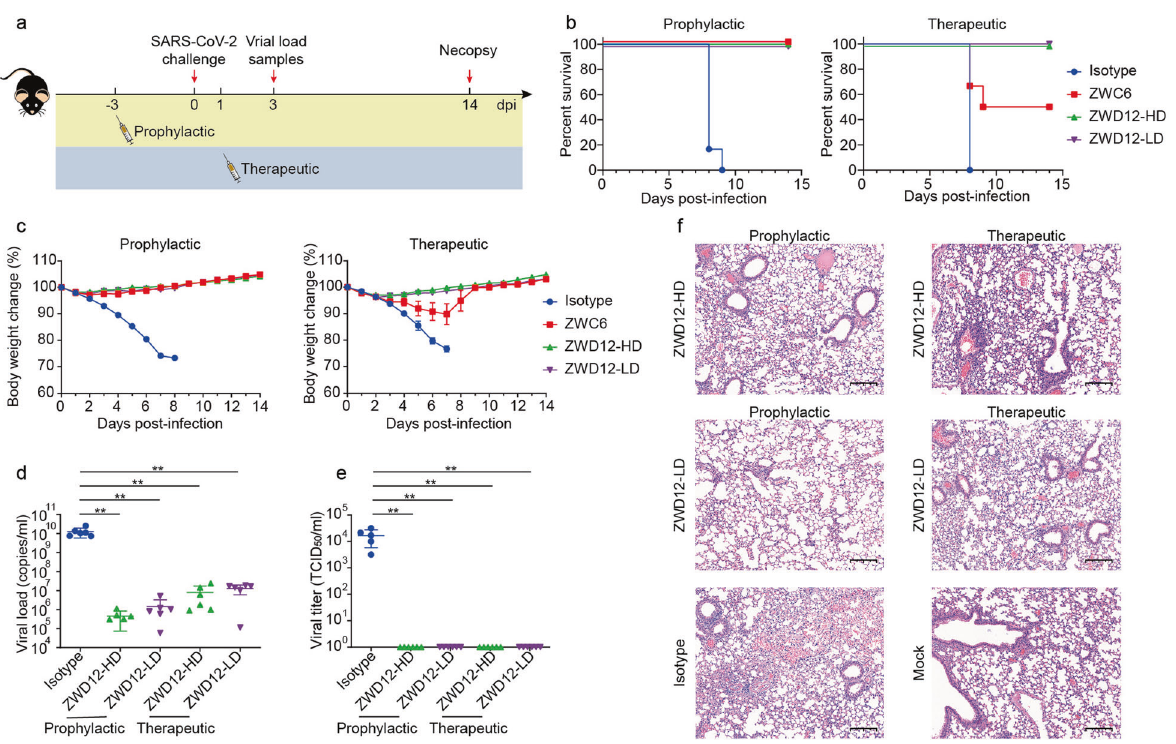
Fig. 4 Prophylactic and therapeutic ef fi cacy of ZWC6 and ZWD12 in the K18-hACE2 transgenic mouse model of SARS-CoV-2 infection. a Prophylactic and therapeutic study schema. b Survival rates of K18-hACE2 transgenic mice ( n = 6) in the prophylactic and therapeutic groups. Isotype, a control antibody-targeted anthrax protective antigen. ZWD12-HD, treatment with ZWD12 at a high dose of 10 mg/kg. ZWD12-LD, treatment with ZWD12 at a low dose of 2 mg/kg. c Body weight changes of mice in the prophylactic and therapeutic groups. The mean ± SD are shown ( n = 6). d Virus copy numbers in the lungs on day 3. ** P < 0.01. e Viral titers in the lungs on day 3. ** P < 0.01. f Histopathological changes in the lungs of SARS-CoV-2-infected mice collected at day 3. Scale bars, 200 μ